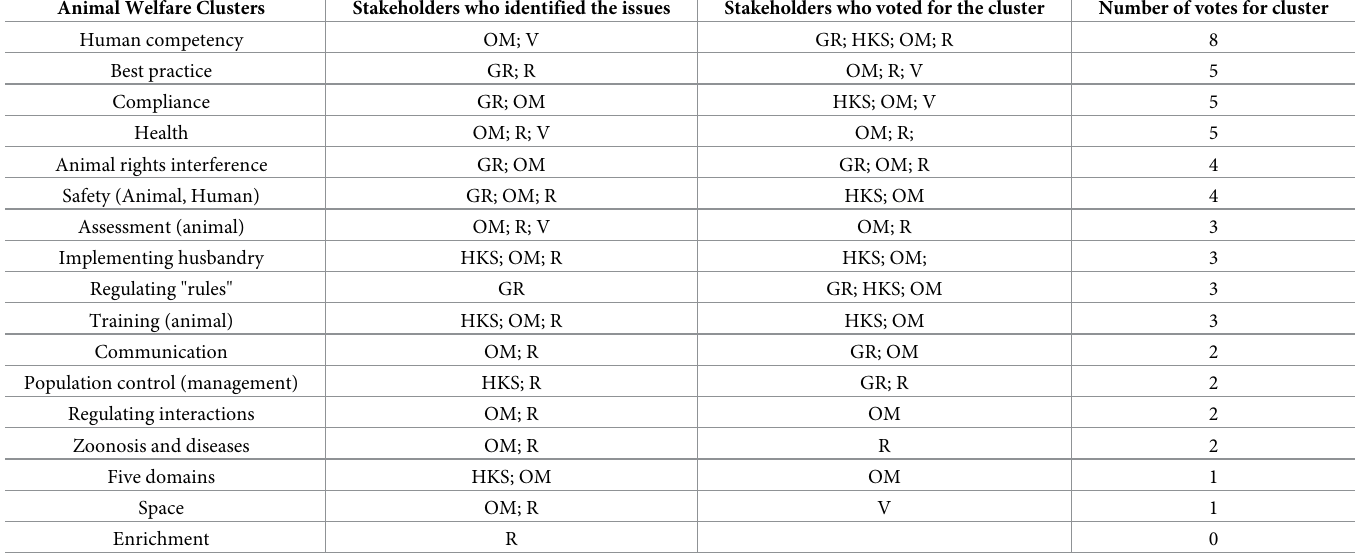
Table 1. Animal welfare clusters and votes (OM = Owners and Manager; R = Researchers; HKS = Handlers/Keepers/Staff; GR = government Representatives; V = veterinarians). Full details in S4 Table. Animal Welfare